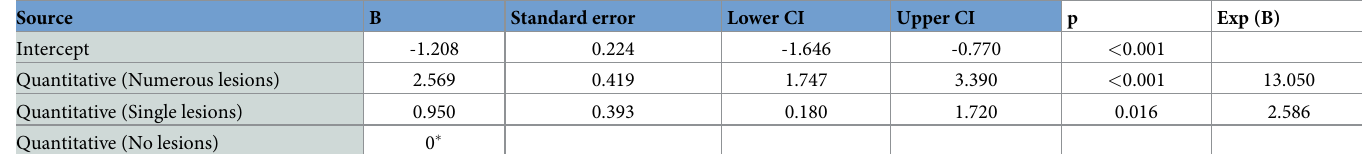
Table 2. Effect of qualitative severity of lesions in lymph nodes on the presence of M . avium in the generalized linear binary model ( � reference category).